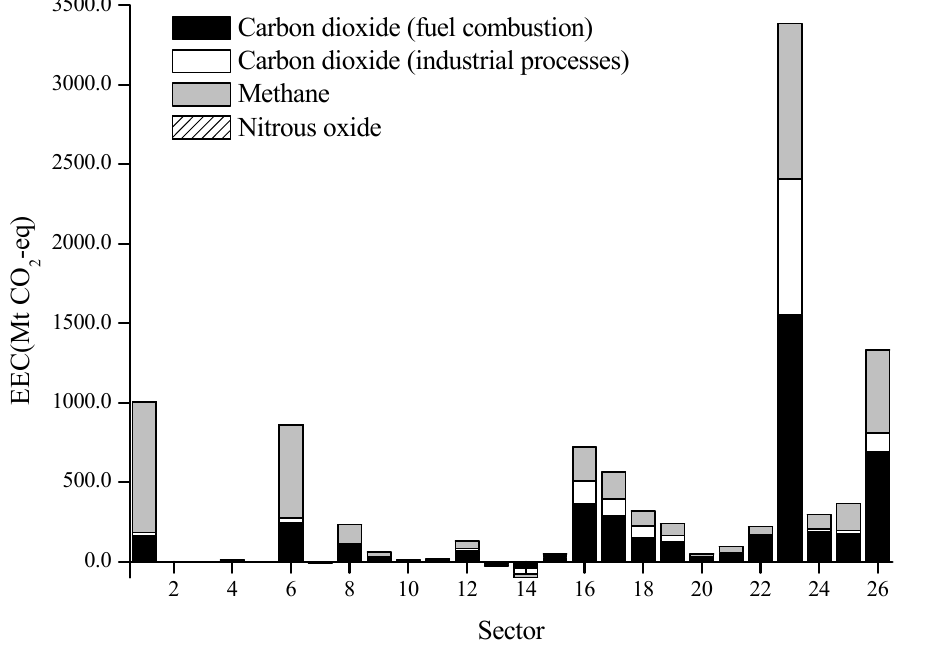
Figure 5. GHG emissions embodied in domestic consumption (EEC) by